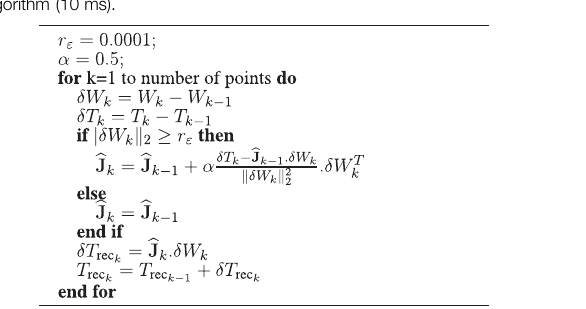
Algorithm 2 | Reconstruction of the instrument tip based on the Broyden algorithm (10